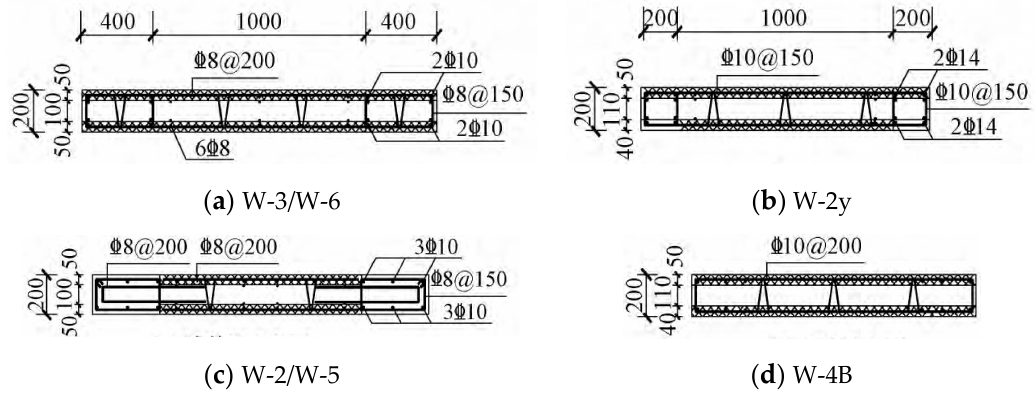
Figure 1. Detail of superimposed slab shear wall.